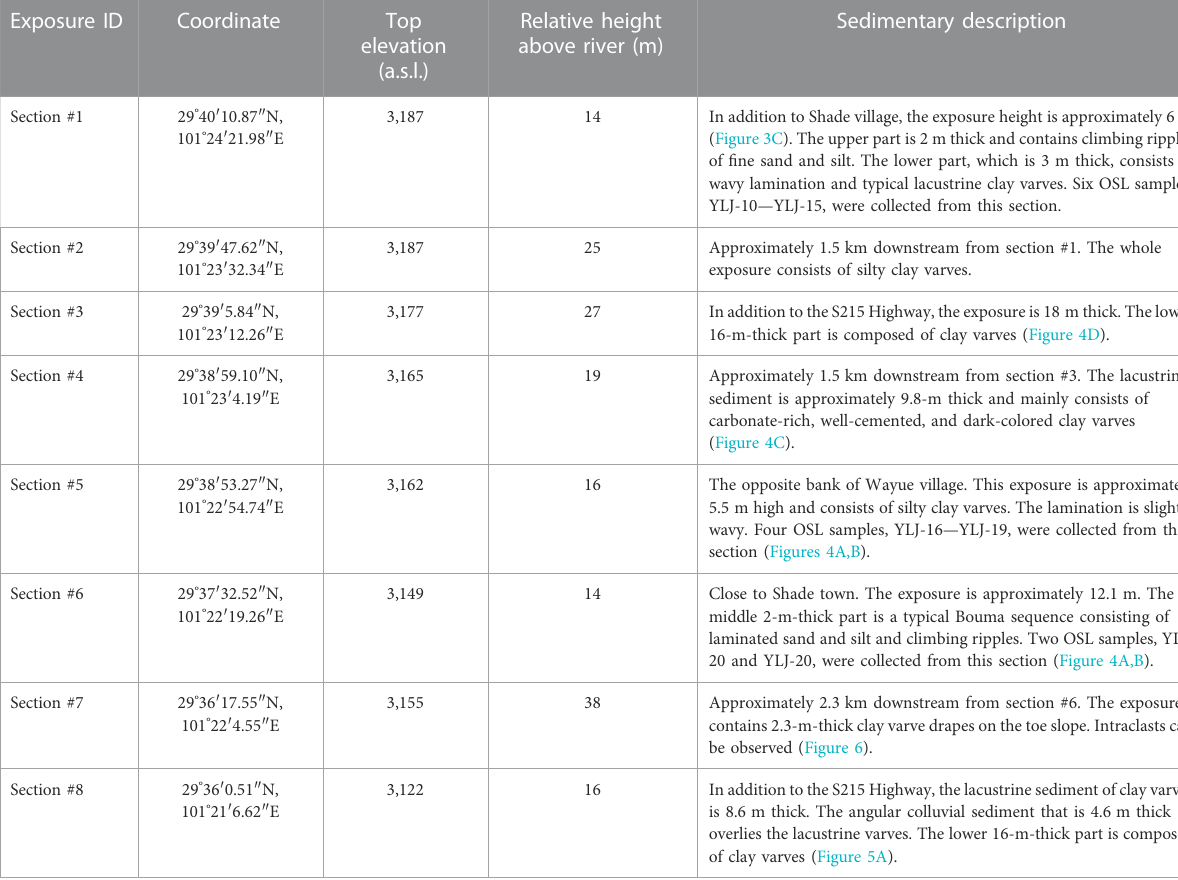
TABLE 1 The elevations of lacustrine exposures and simple descriptions of sedimentary characteristics.